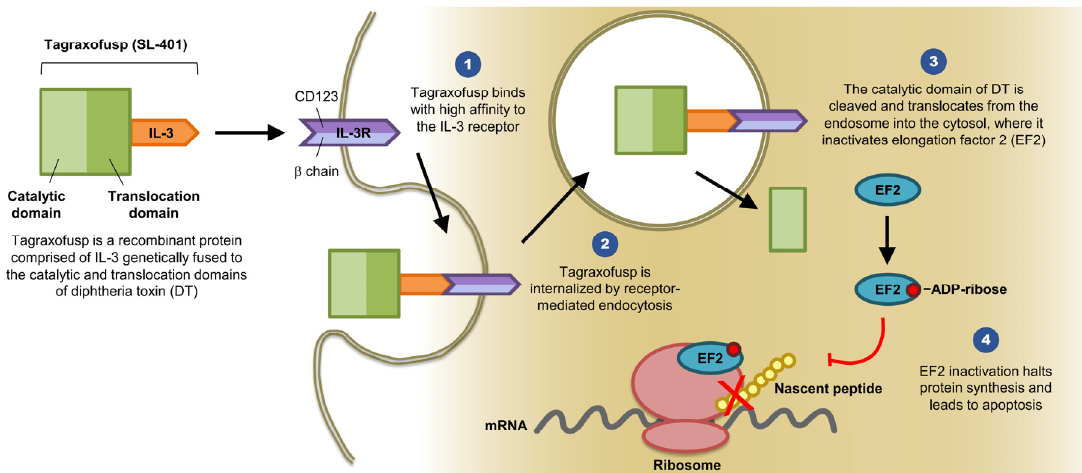
Figure 1. SL-401 Structure and Mechanism of Action (provided by Stemline Therapeutics, Inc., New York, NY 10022, USA). Abbreviations: IL-3, interleukin 3; IL-3R, interleukin 3 receptor; DT, diphtheria toxin; EF2, elongation factor 2; mRNA, messenger ribonucleic acid; ADP, adenosine diphosphate.